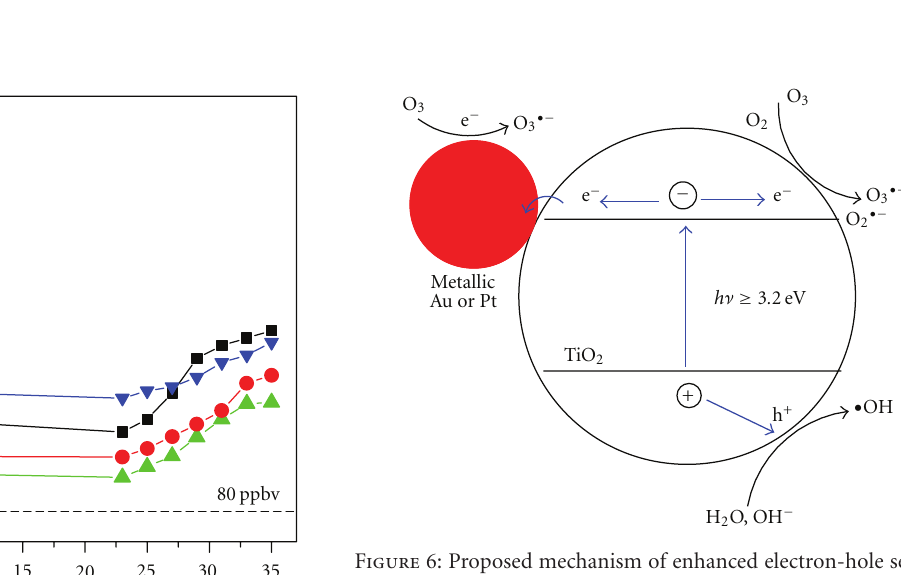
Figure 4: Time courses for the outlet concentration of formaldehyde (a) and ozone (b) with irradiation time in the 35h O 3 + UV 254nm photocatalysis.